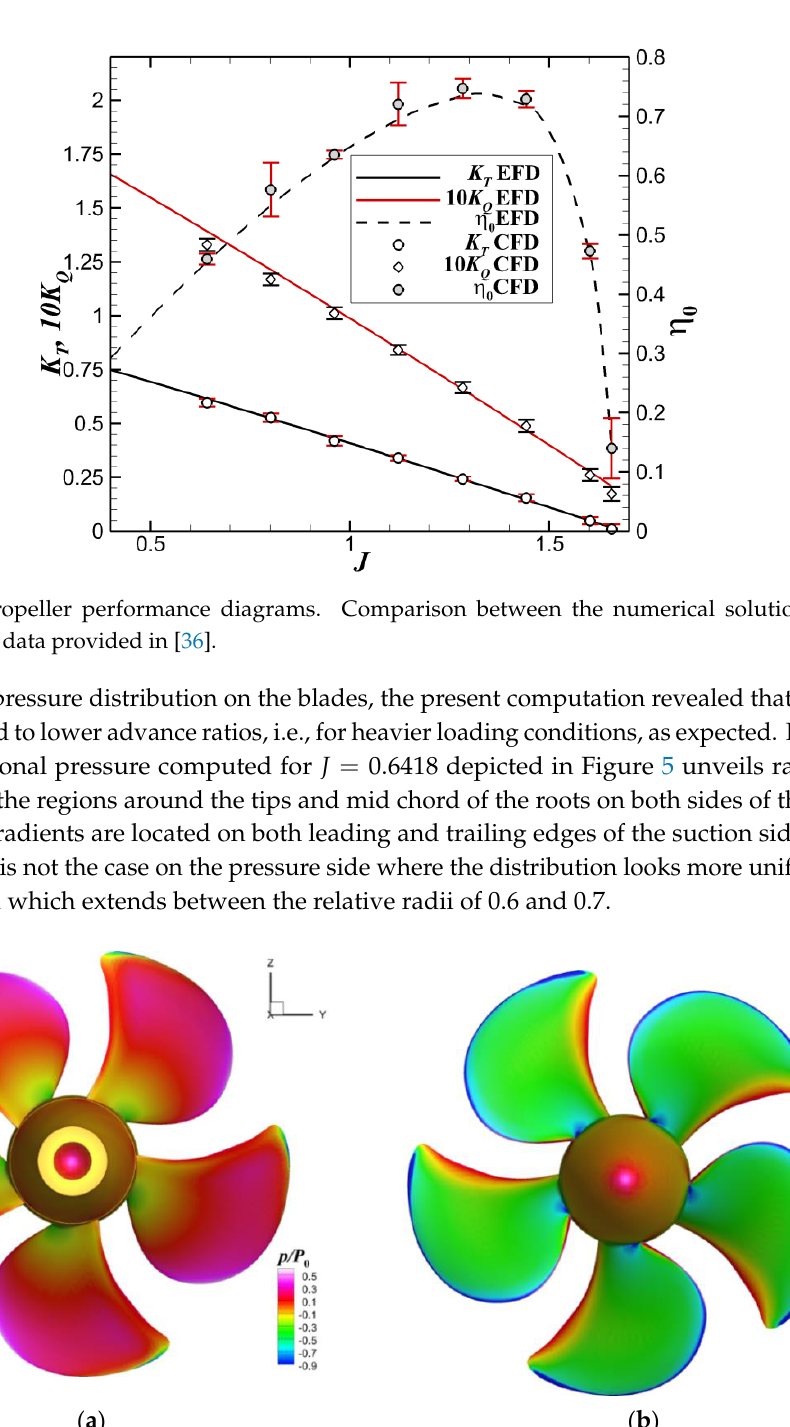
Figure 5. Pressure distribution on the propeller blades computed at J = 0.6418. ( a ): pressure side; ( b ): suction side.